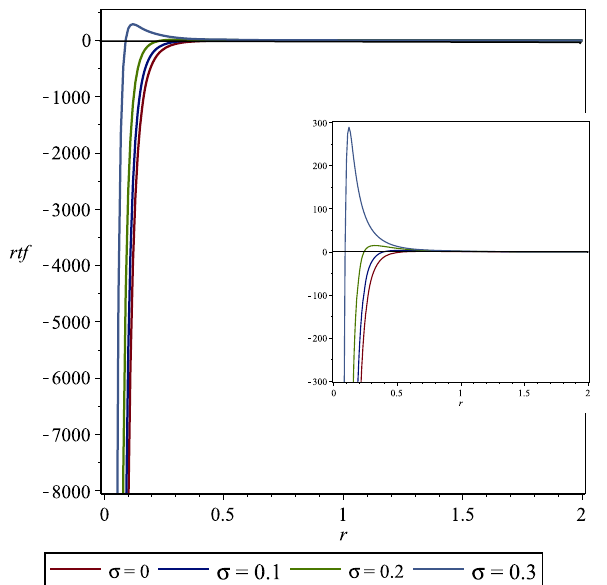
Fig. 3 Angular tidal force for a Kiselev BH surrounded by radiation for chosen values of the radiation parameter, also we have q = 0 . 6, M = 1 and b = 100